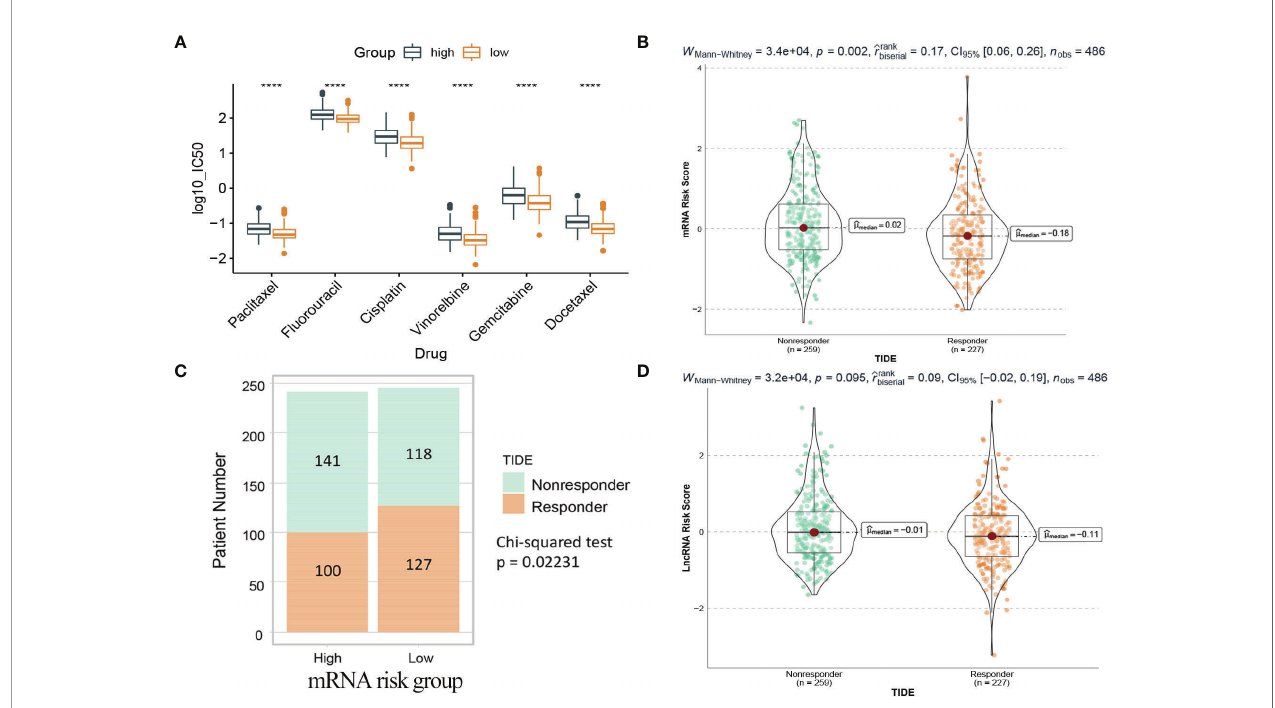
FIGURE 13 | Drug prediction and TIDE immunotherapy prediction analyses. (A) Box plot of IC50 values of six chemotherapy drugs between the two risk groups in the mRNA model. (B) The mRNA risk score between TIDE predicted responders and non-responders. (C) Distribution of TIDE responders and non-responders in the mRNA risk groups. (D) The lncRNA risk score between TIDE predicted responders and non-responders. Responder: the patient who responds to the immune checkpoint inhibitors. Nonresponder: the patient who does not respond to the immune checkpoint inhibitors. ****: